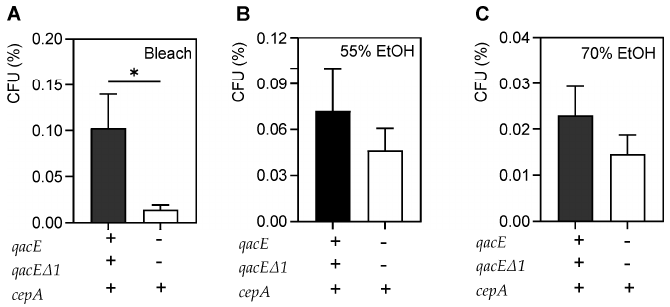
Figure 3 . Comparison of survival of microbicide exposure of microbicide-resistant and -susceptible strains. Average percent survival of four microbicide-resistant, planktonic bacteria vs. six microbicide-sensitive strains after exposure to antiseptics at proper dwell times. ( A ) Microbicide-resistant strains survived more than microbicide-sensitive bacteria after 4 min of bleach exposure ( p = 0.01). No differences were seen after 1 min of 55% ethanol exposure ( B ), or 1 min of 70% ethanol exposure ( C ). The bars show mean survival and error bars represent standard deviation. A p -value of ≤ 0.05 was considered significant. * p -value < 0.05.